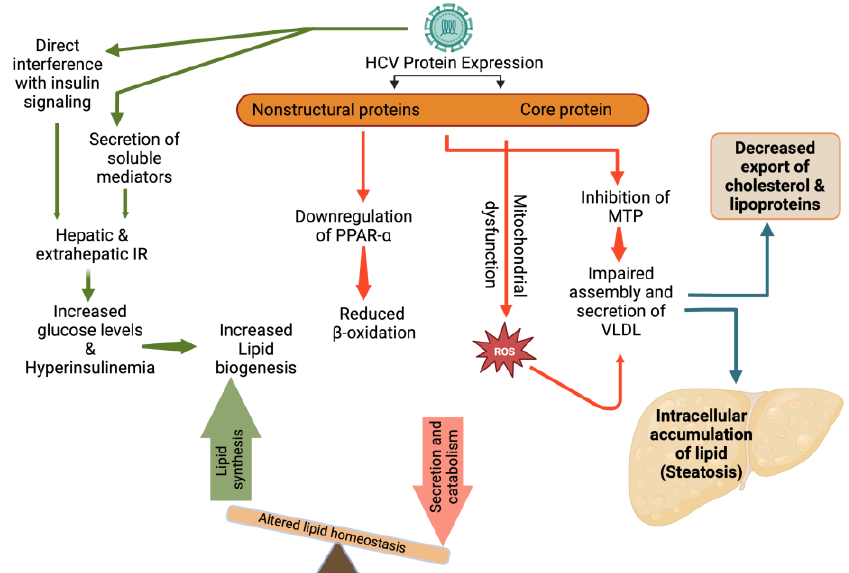
Figure 3. HCV induced alterations in lipid metabolism and steatosis. IR: Insulin resistance; PPAR- α : Peroxisome proliferator-activated receptor- α ; ROS: Reactive oxygen species; MTP: Microsomal triglyceride transfer protein; VLDL: very-low density lipoproteins.